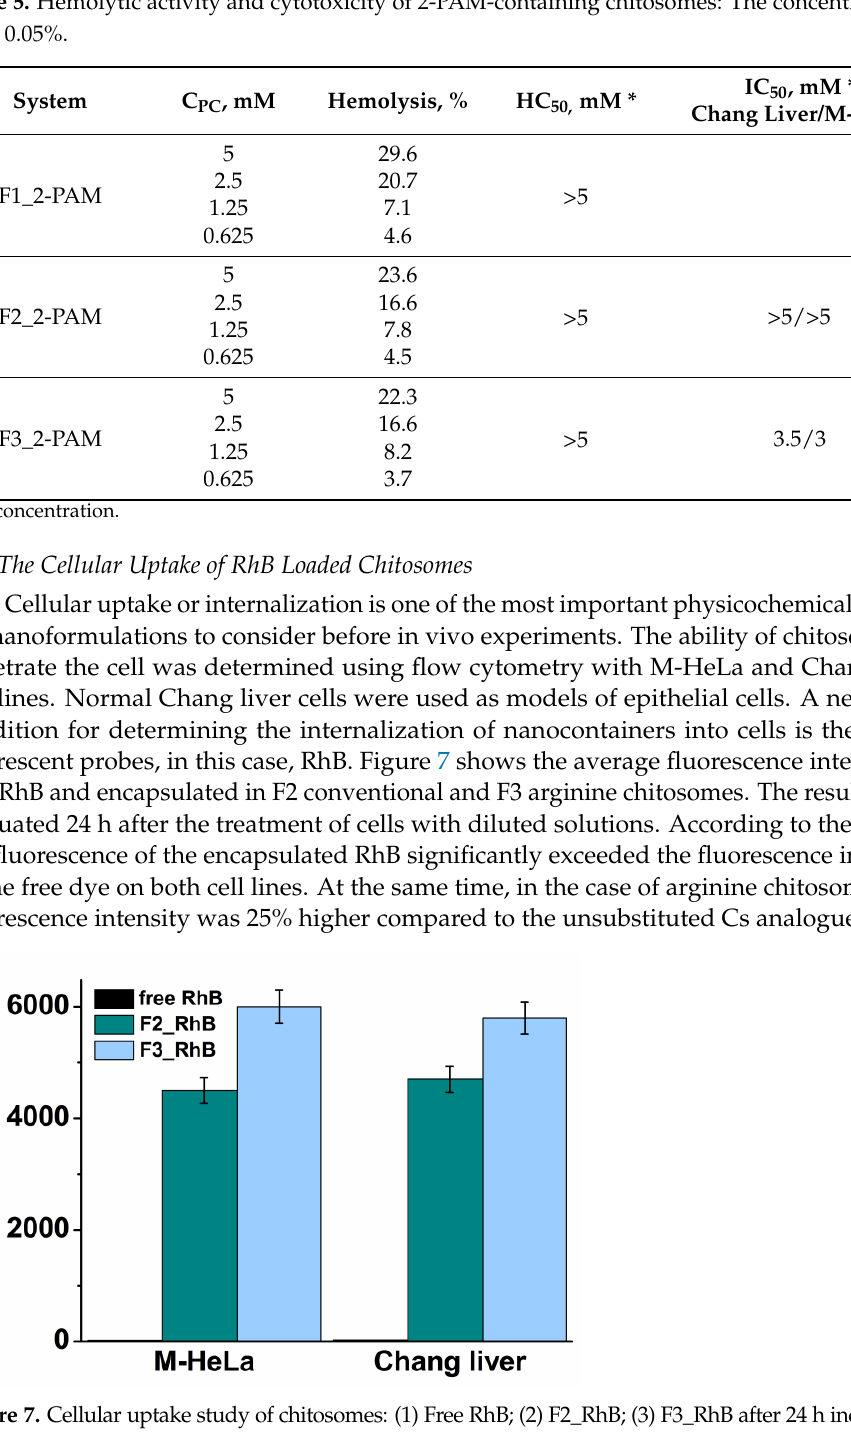
Figure 8. In vitro cellular uptake study of RhB-loaded chitosomes; (F2 and F3); M-HeLa cell line. Blue channel: DAPI fluorescence (nuclei); red channel: RhB fluorescence (chitosomes).